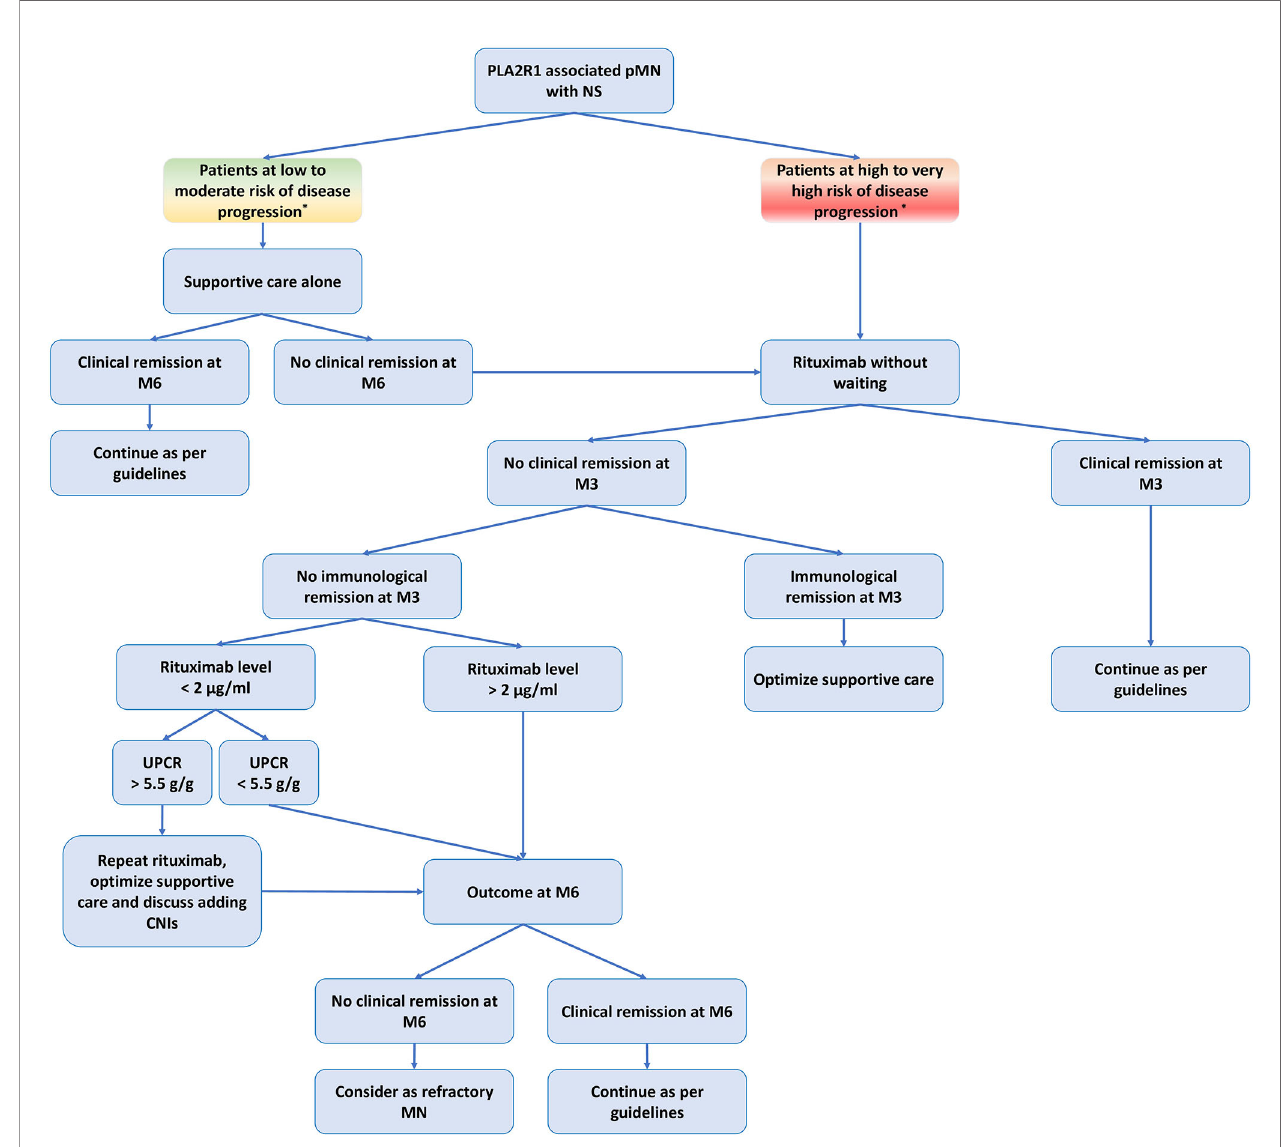
FIGURE 3 | Treatment of primary membranous nephropathy based on risk assessment of disease progression and rituximab immunomonitoring. CNIs, calcineurin inhibitors; M3, month-3 (3 months after rituximab infusion); M6, month-6 (six months after rituximab infusion); NS, nephrotic syndrome; pMN, primary membranous nephropathy; PLA2R1, phospholipase A2 receptor type 1; RTX, rituximab; UPCR, urine protein/creatinine ratio. *Low to moderate risk of disease progression: negative epitope spreading and anti-PLA2R1 titer < 150 RU/ml, and no severe complication related to NS, and reduction of proteinuria under optimal supportive care and no deterioration of kidney function. High to very high risk of disease progression: positive epitope spreading, and/or anti-PLA2R1 titer > 150 RU/ml, and/or severe complication related to NS, and/or high proteinuria (> 8 g/d) despite optimal supportive care and/or deterioration of kidney function. Urine low-molecular- weight proteins and urinary IgG excretion have been shown to correlate with disease progression in patients with pMN, but these markers are rarely used in daily practice. Serum rituximab level analyzed by ELISA (LISA-TRACKER Duo Rituximab, Theradiag © Croissy Beaubourg, France) three months after the last injection. The limit of detection de fi ned by the manufacturer is 2